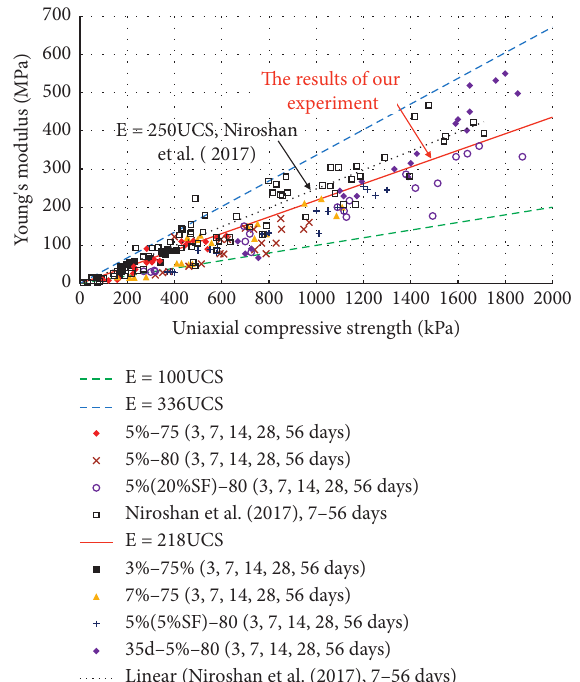
Figure 9: Plot of the change in the elastic modulus with the strength of cemented mine backfill.